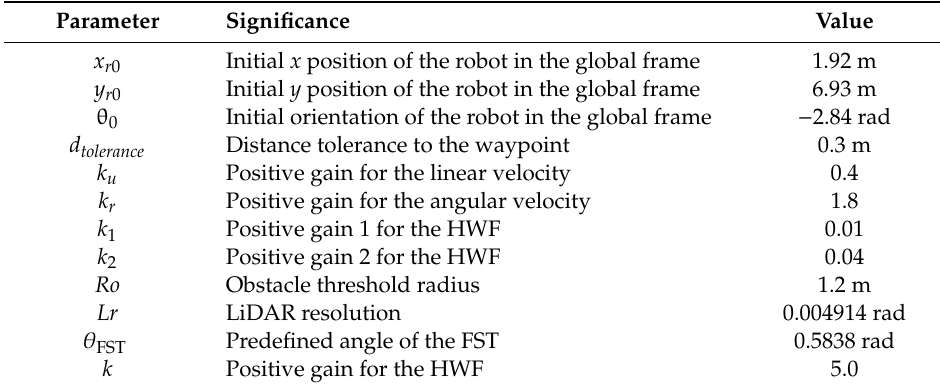
Table 1. Simulation parameters used to test the HWF.